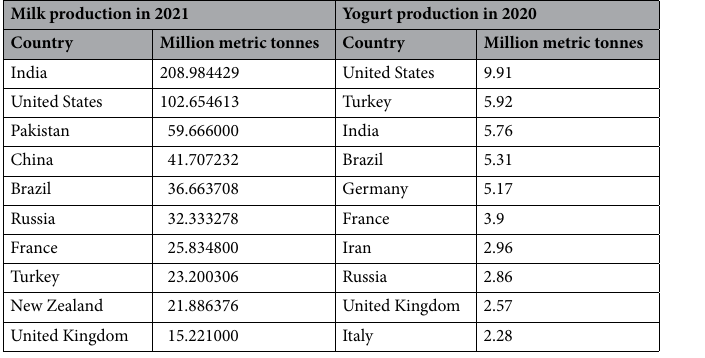
Table 1. Top milk and yogurt producing countries in the